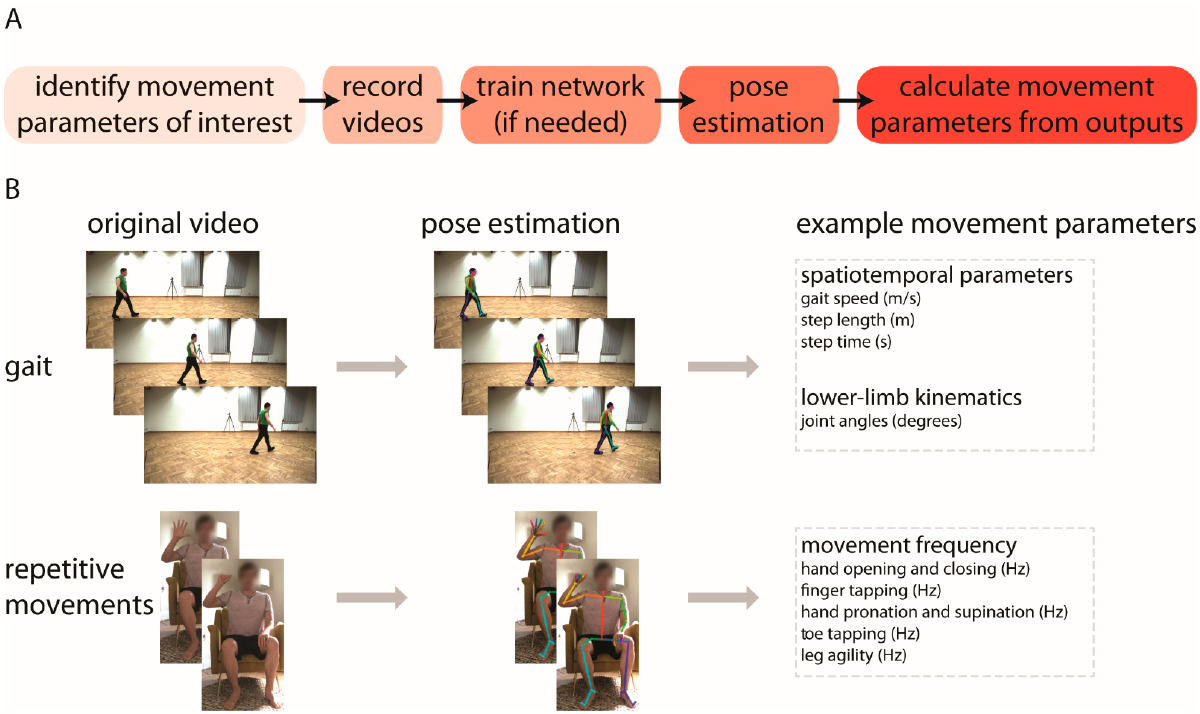
Figure 1. ( A ) Basic workflow for using pose estimation to measure movement kinematics from video; ( B ) Example applications of using pose estimation to quantify spatiotemporal and kinematic gait parameters (top) and frequencies of repetitive upper and lower extremity movements (bottom). These applications are described in greater detail in [14,15]. The gait images shown in ( B ) are taken from the GPJATK dataset [16].